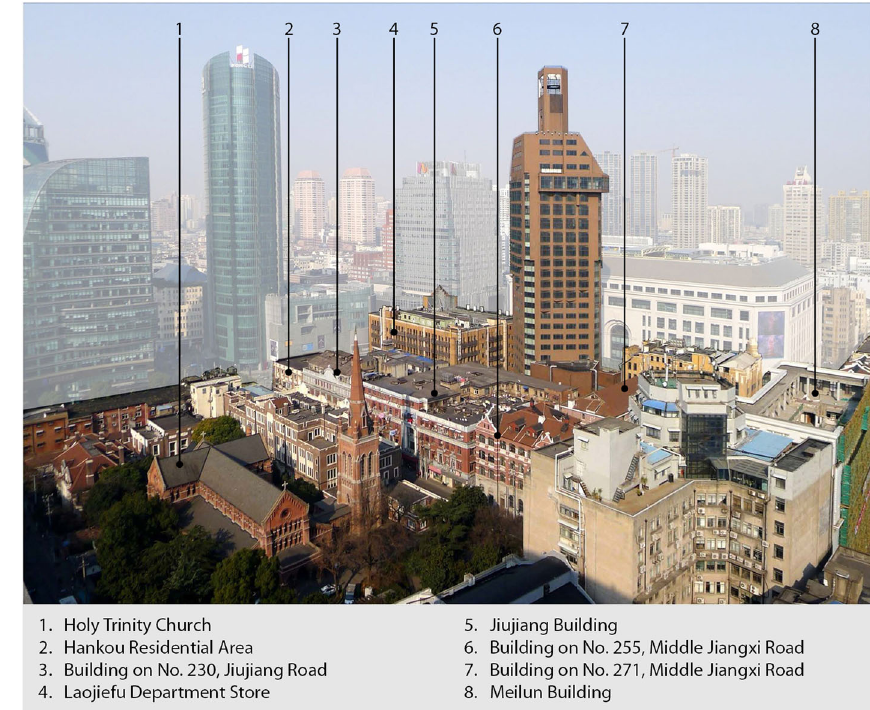
Fig. 4 Heritage architecture sites surrounding the SECEP Building (Source: Based on photographs provided by